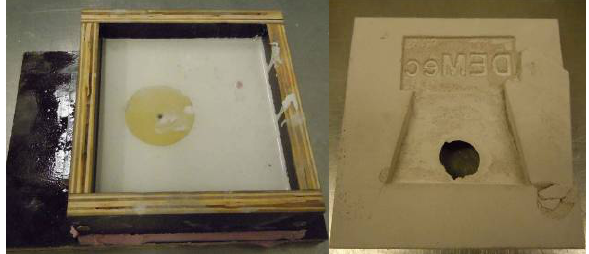
Figure 8. Box containing the model with the gating system and the slurry, and final ceramic mould with defects.